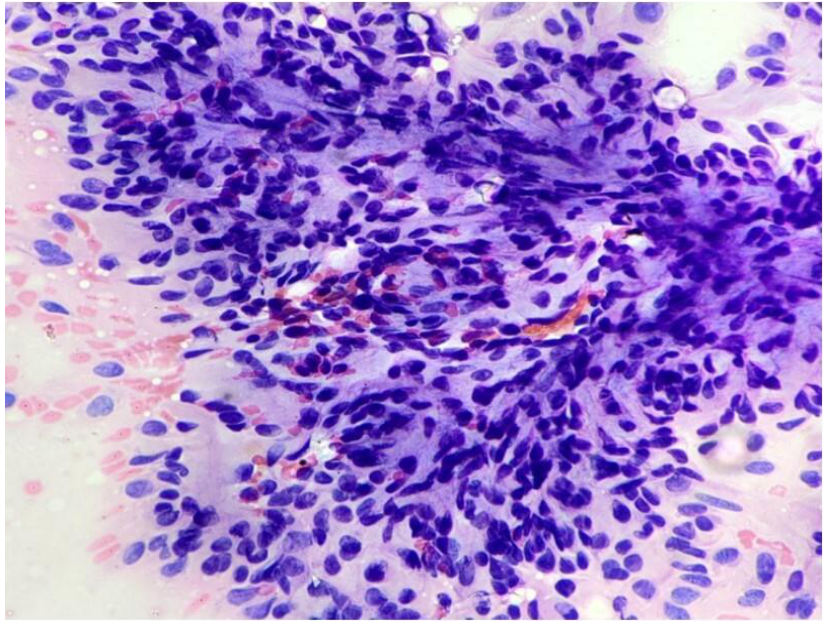
Fig. 1. Cytology image of Pleomorphic Adenoma showing round to oval epithelial cells and spindle-shaped myoepithelial cells in chondromyxoid stroma (H&E, 400X). Of the 43 cases, 33 were found in the parotid gland. Eight were seen in polymorphs, plasma cells, and lymphocytes with plump epithelial and the submandibular gland and 2 in minor salivary glands. Smears of chronic myoepithelial cells against a hemorrhagic and fibromyxoid background (Fig. sialadenitis were cellular and showed inflammatory cells comprising 2).